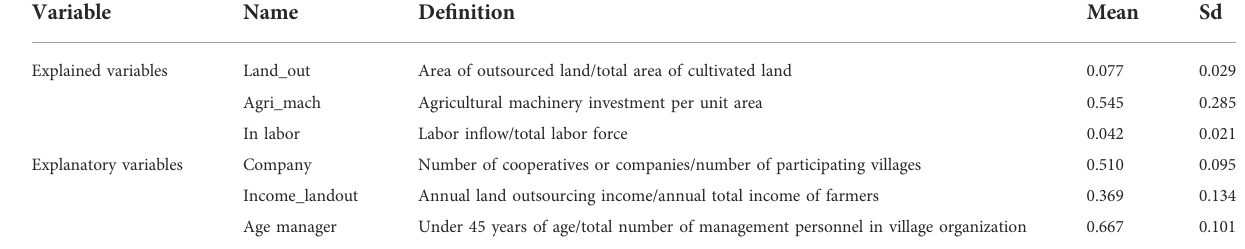
TABLE 2 Variable de fi nition and